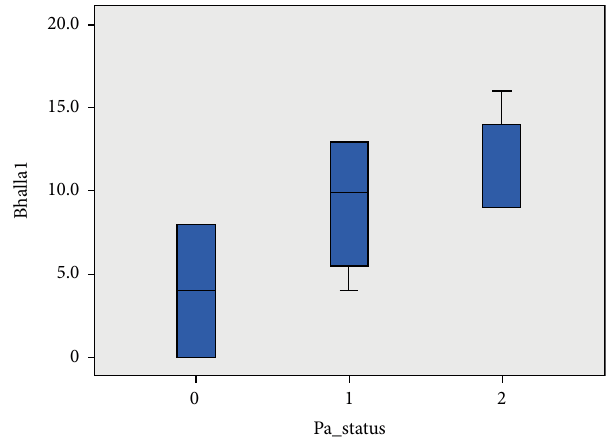
Figure 4: Bhalla scores among patients not colonized, intermittently and chronically colonized with Pseudomonas aeruginosa . (0: patients not colonized, 1: patients intermittently colonized with P. aeruginosa , 2: patients chronically colonized with P. aeruginosa